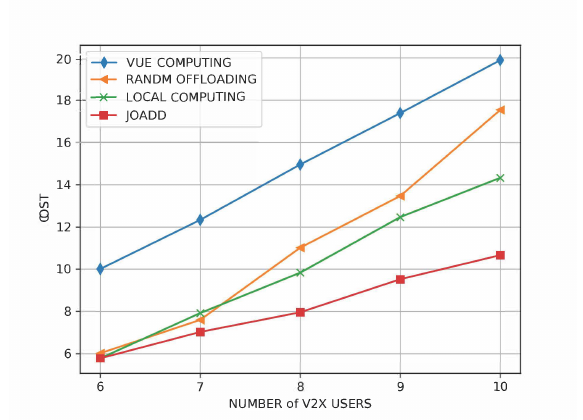
Figure 7. The effect on cost of the number of pieces of